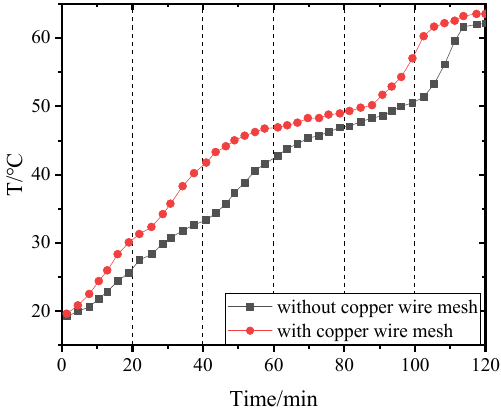
Figure 18. Temperature of point 1 in PCM-2 changing with time.